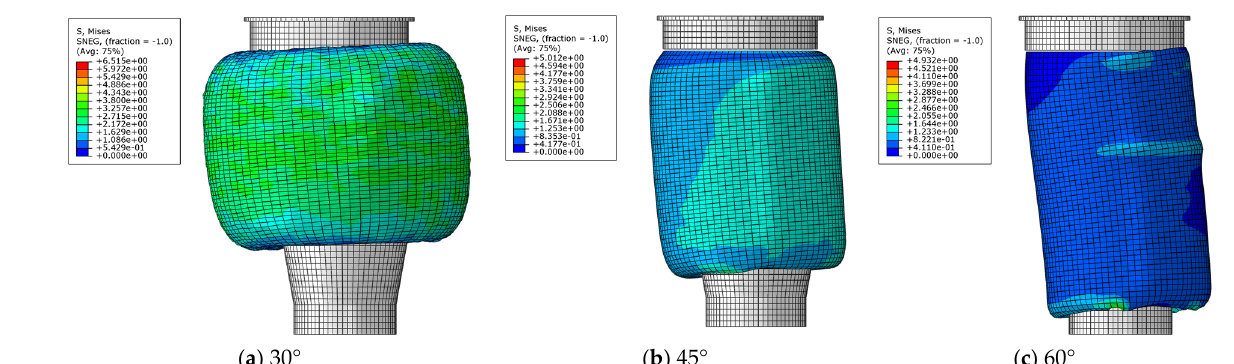
Figure 10. The deformation of bellows under different cord angle.